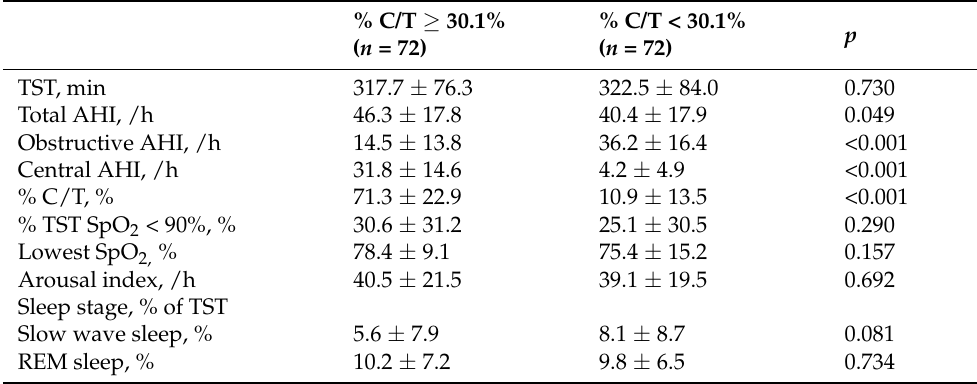
Table 3. Polysomnographic